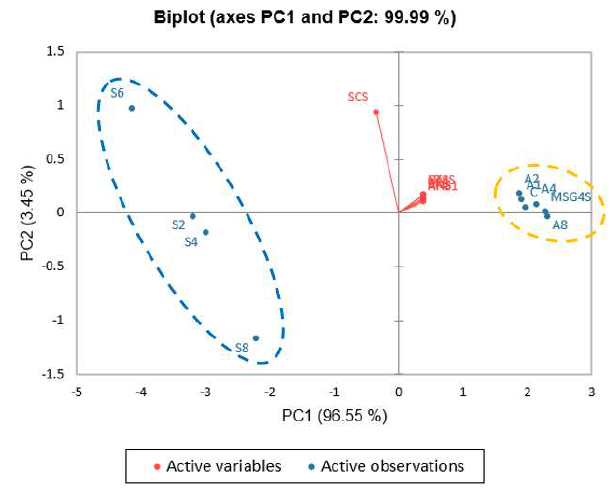
Figure 6. PCA biplot of flavor attributes in unseasoned and standard soups with different SGM concentrations. Differences among samples were identified using cluster analysis, and groups are represented by blue and yellow ovals ( p ≤ 0.05). C: Control standard soup sample, A1: 0.1% SGM standard soup, A2: 0.2% SGM standard soup, A4: 0.4% SGM standard soup, A8: 0.8% SGM standard soup, MSG4S: 0.4% MSG standard soup, and S1–S8: 0.1–0.8% SGM unseasoned soup, respectively.